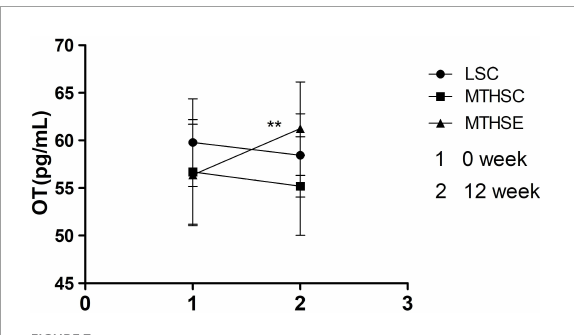
FIGURE7 The effect of exercise on plasma oxytocin (OT) concentration. 1, Plasma OT concentration at week 0; 2, Plasma OT concentration at week 12; ** p < 0.01 , compared with